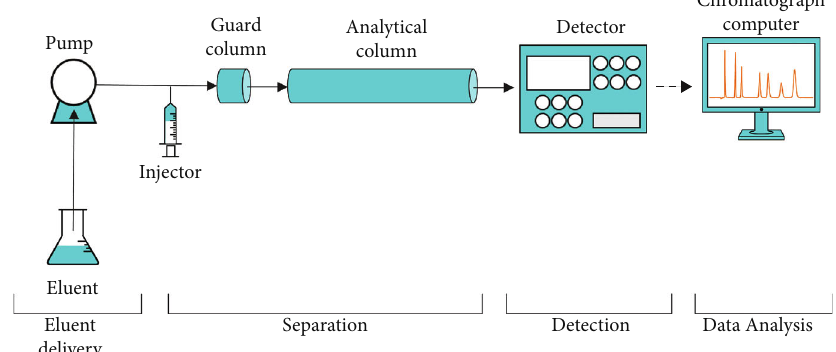
Figure 3: Ion chromatograph fl